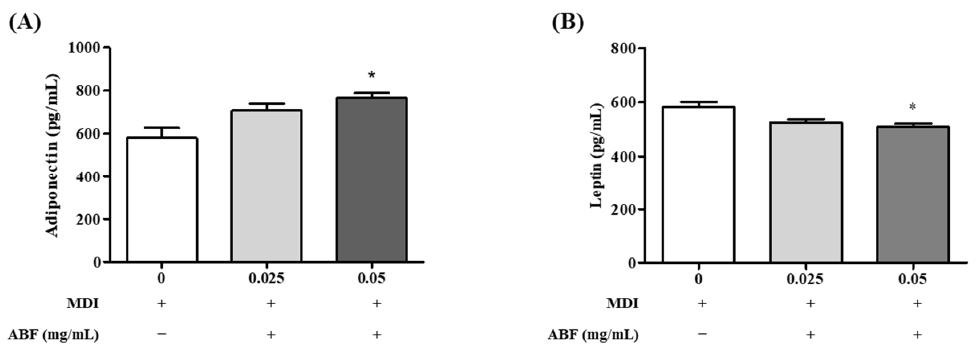
Figure 8. Effects of Aronia bioactive fraction (ABF ® ) on adipokine secretion in 3T3-L1 adipocytes. 3T3-1 adipocytes were treated with ABF ® (0.025 and 0.05 mg/mL). ( A ) Adiponectin significantly increased in ABF ® (0.05 mg/mL). ( B ) Leptin significantly decreased in ABF ® (0.025 and 0.05 mg/mL). Data represented mean ± SEM. * p < 0.05 compared with the MDI control group.